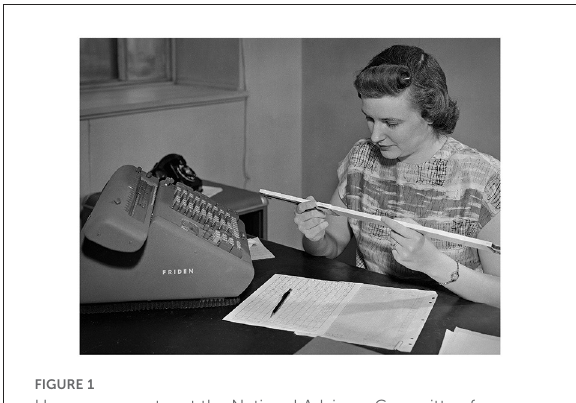
FIGURE1 Human computer at the National Advisory Committee for Aeronautics (NACA) Lewis Flight Propulsion Laboratory using a slide rule and adding